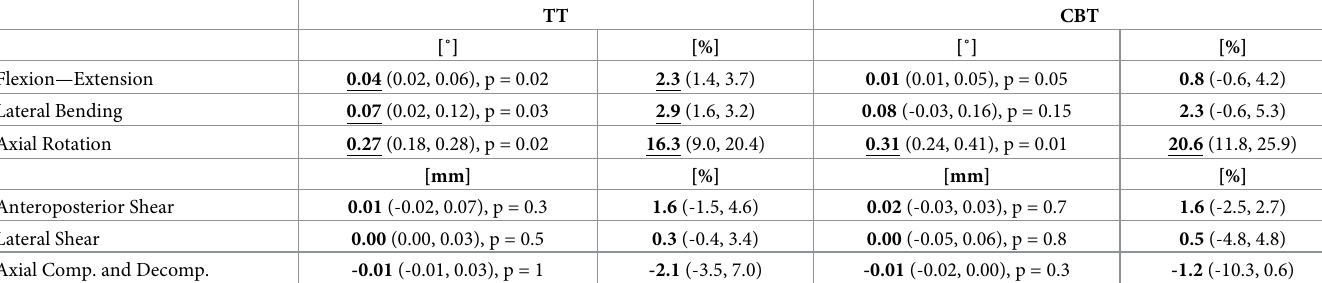
Table 3. Reduction in range of motion due to the addition of one horizontal